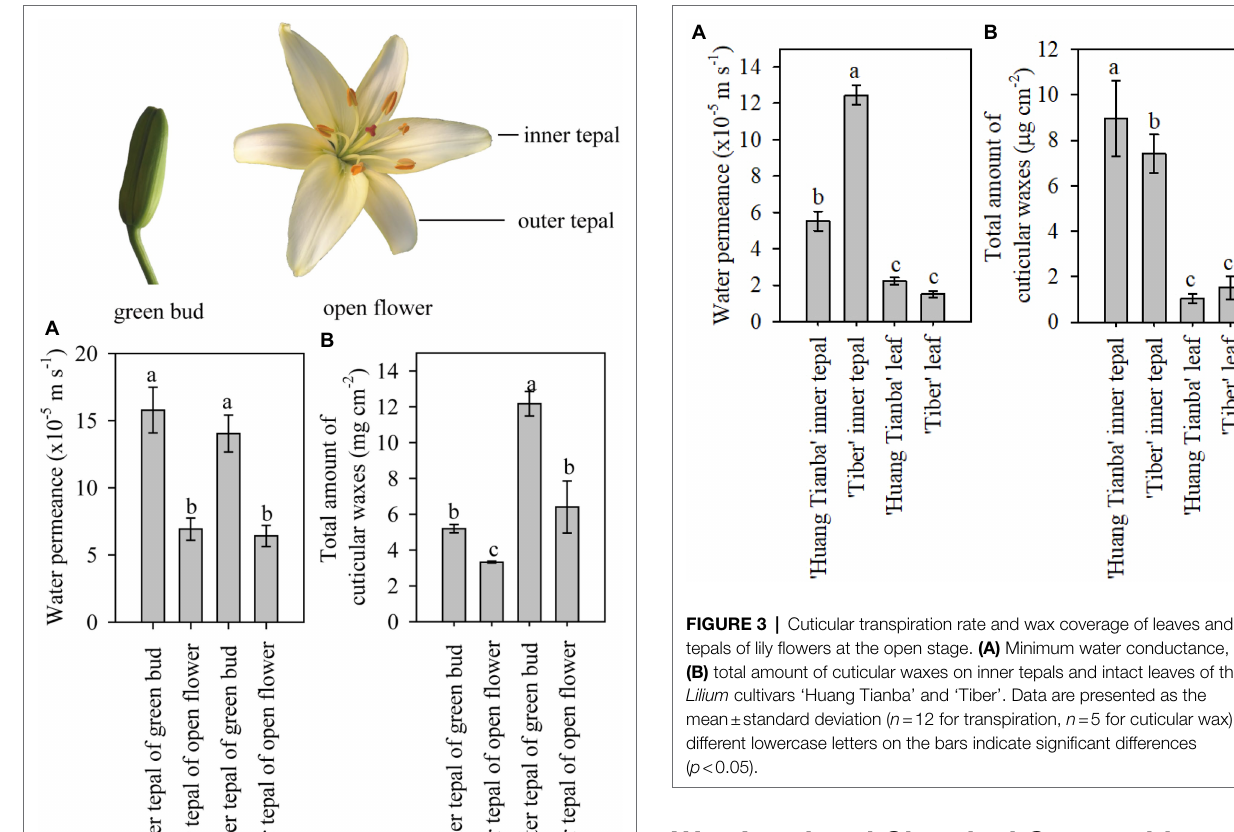
Wax Load and Chemical Composition at Different Tepal Development Stages As the primary barrier to non-stomatal transpiration is determined by the wax pattern in the cuticle (Riederer and Schreiber, 2001), the composition of the wax on the leaves and tepals at the green bud and open flower stages was analyzed. The overall wax coverage was 12.17 ± 0.69 μ g cm − 2 and 6.40 ± 1.45 μ g cm − 2 on the outer tepals of the green bud and open flowers, respectively ( Figure 2B ). Lower amounts of wax were detected on the inner tepals of the green buds and open ( Figure 2B ). The waxes on the tepals of the green buds and open flowers were composed of very-long-chain fatty acids, primary alcohols, and n -alkanes ( Figure 4 ). The most abundant wax components were n -alkanes, which comprised 73.28% (of the total wax) on the outer tepals and 70.27% on the inner tepals at the green bud stage, and 76.68% on the outer tepals and 77.34% on the inner tepals of the open flowers ( Figure 4 ). Primary alcohols occurred also in relatively higher proportions in the cuticle on the green bud tepals (4.09% outer and 8.30% inner) compared to that on the tepals of the open flowers (1.29% outer and 6.07% inner, Figure 4 ). There were no obvious differences in the fatty acid content of the wax on the tepals at the green bud and open flower stages. Very-long-chain alkyl esters and cyclic sterols were detected only in the wax on the tepals of the open flowers ( Figure 4 ; Supplementary Table S1 ).